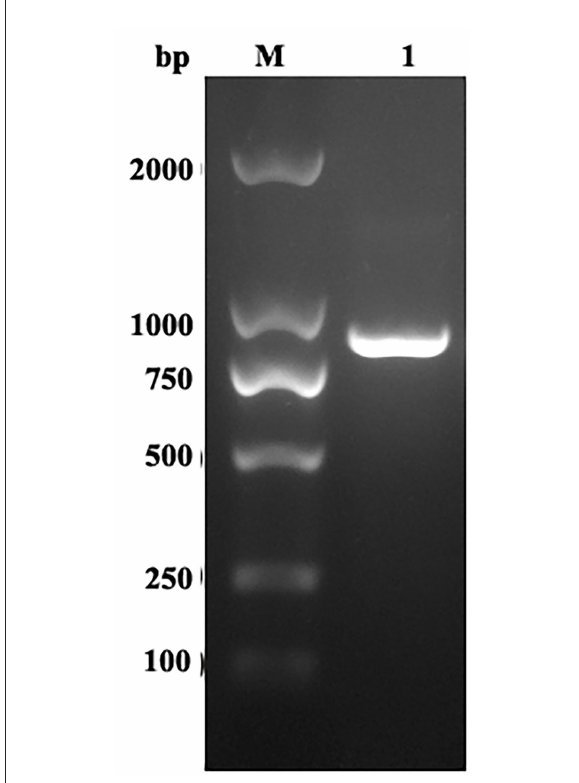
FIGURE1 RT-PCR amplification of EmROM1. M: DNA Molecular Weight Standard DL2000. Lane 1: Amplification products of EmROM1.